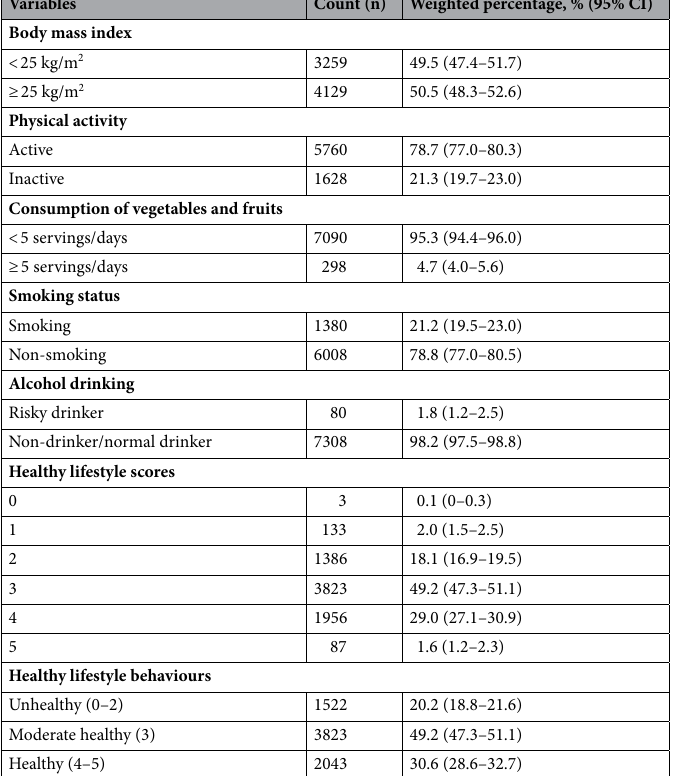
Table 2. Healthy lifestyle factors of study population (n =